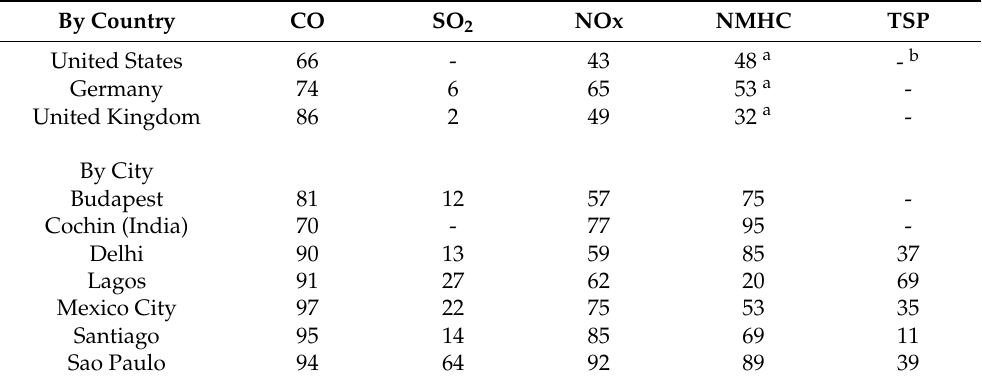
Table A2. Illustration of motor vehicle contribution (% of emissions) to reactants in cities. (Based on tabulations from